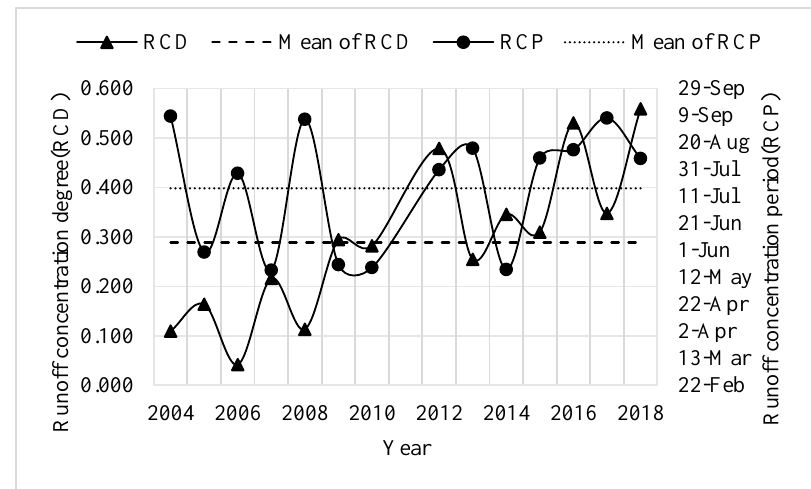
Figure 8. Runoff-concentration degree/period in the Dongdaqiao station from 2004 to 2018.